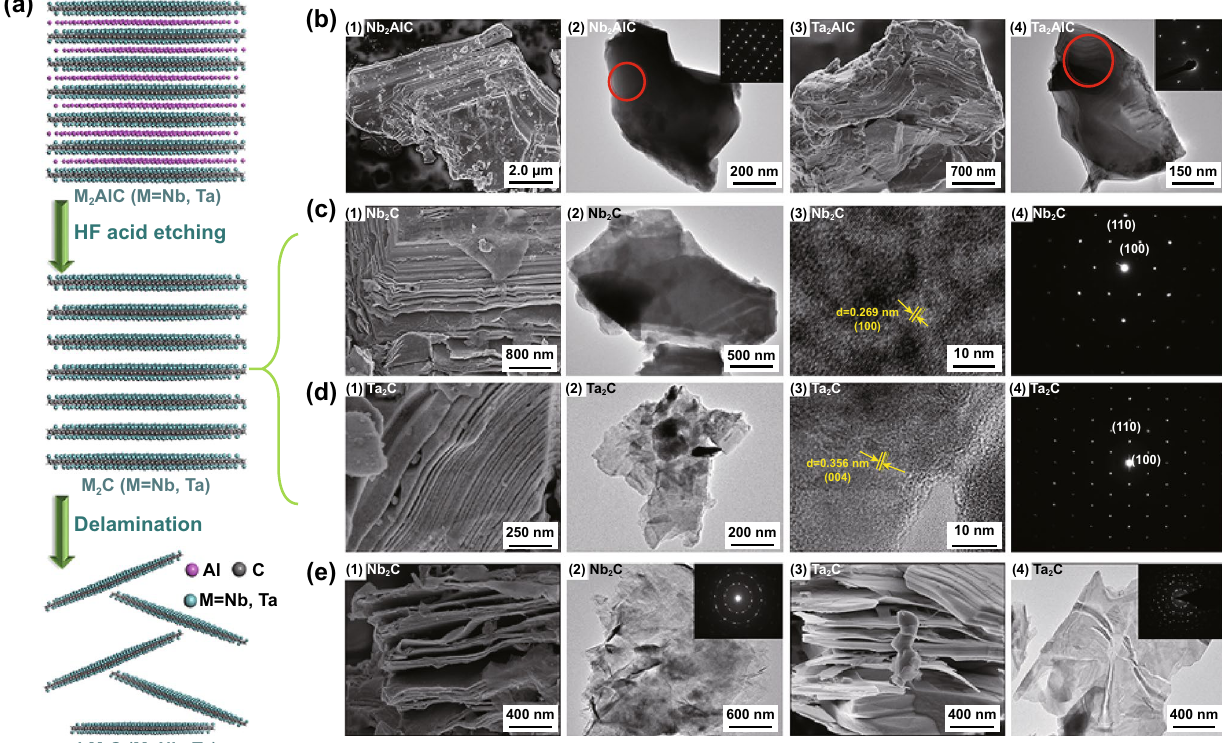
Fig. 3 a Schematic illustration of the synthesis process for Nb 2 C and Ta 2 C nanosheets by the two-step exfoliation process. b SEM images of Nb 2 AlC (1) and Ta 2 AlC (3) bulk structure, TEM images and the corresponding SAED patterns (inset in Fig. 2, 4) of Nb 2 AlC (2) and Ta 2 AlC (4) bulk structure. c , d SEM images (1), TEM images (2), HRTEM images (3) and the corresponding SAED patterns (4) of Nb 2 C ( c ) and Ta 2 C ( d ). e SEM images of delaminated d-Nb 2 C (1) and d-Ta 2 C (3), TEM images and the corresponding SAED patterns (inset in Fig. 2, 4) of delaminated d-Nb 2 C (2) and d-Ta 2 C